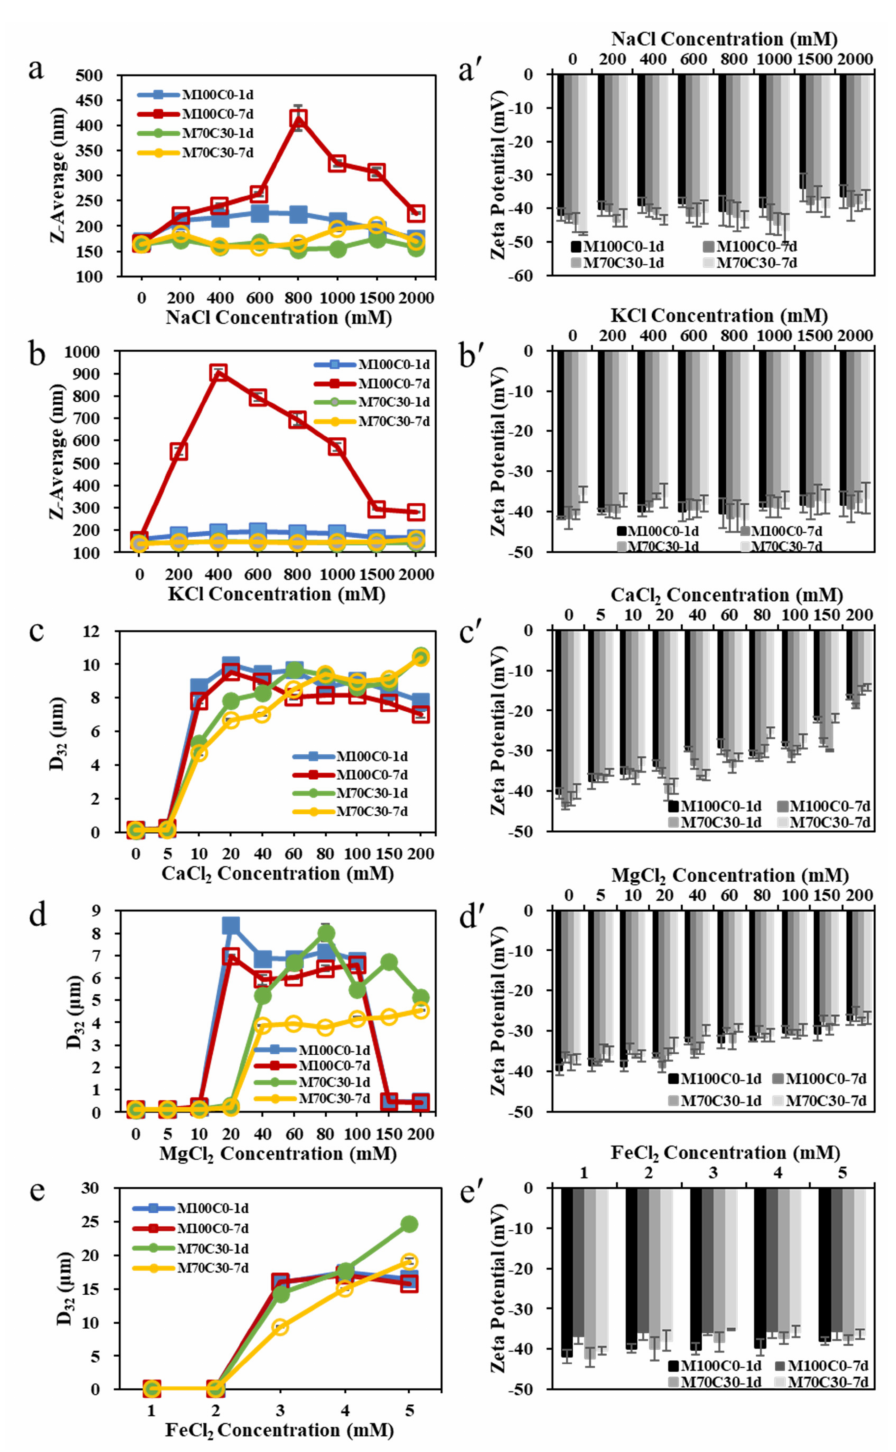
Figure 2. Particle size ( a – e ) and ζ -potential ( a’ – e’ ) of WPI-stabilized emulsions at different ion types and strengths after 1 day’s and 7 days’